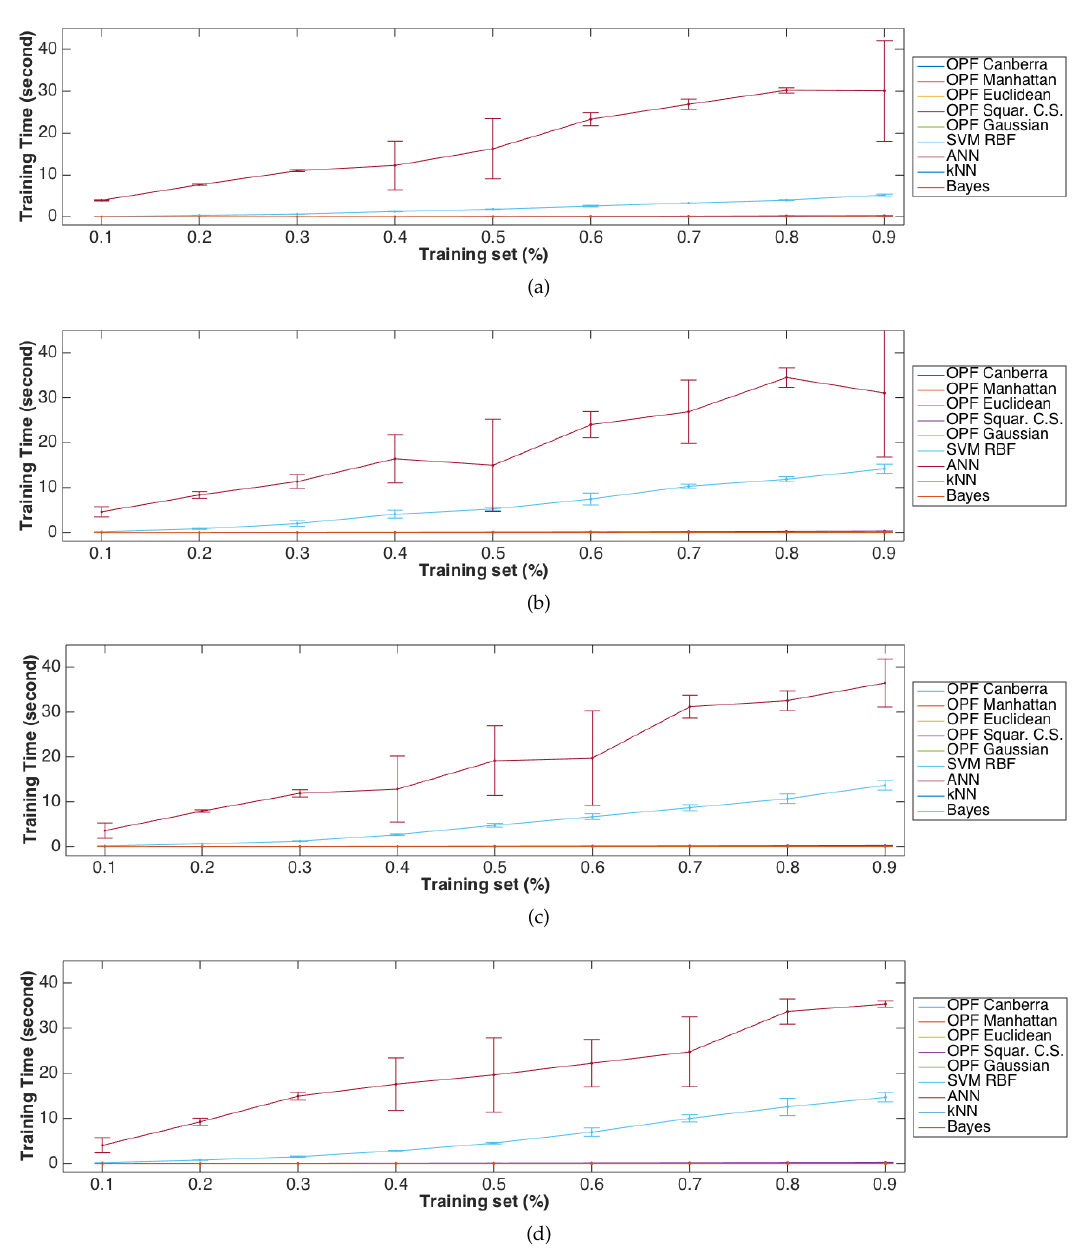
Figure 7. Training time required by the computer classifiers varying the percentage of the used training data from 10 to 90% when applied on the original data and on the same data corrupted with the addition of Gaussian noise: ( a ) 0% (raw data); ( b ) 5%; ( c ) 15%; and ( d )